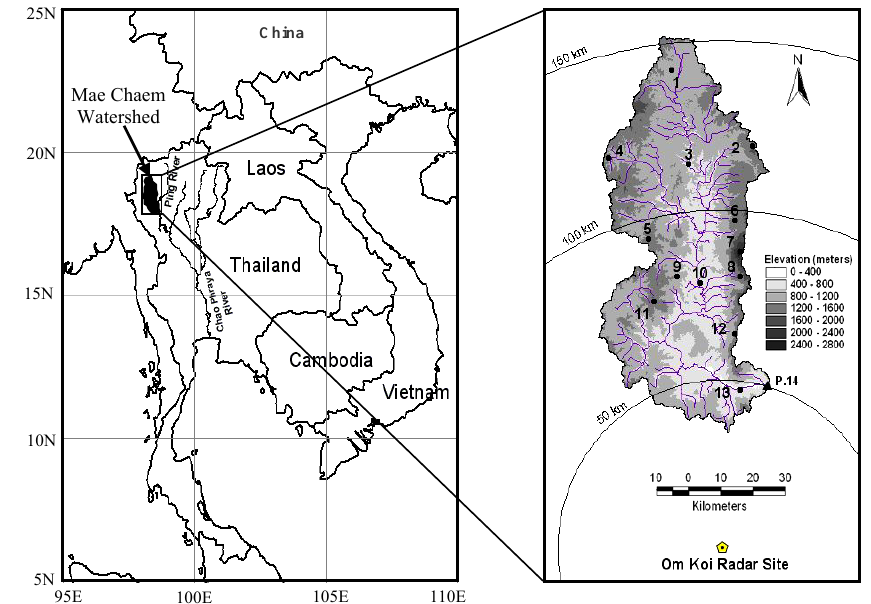
Figure 1. Fig. 1. Mae Chaem Watershed and locations of radar and gauge stations.